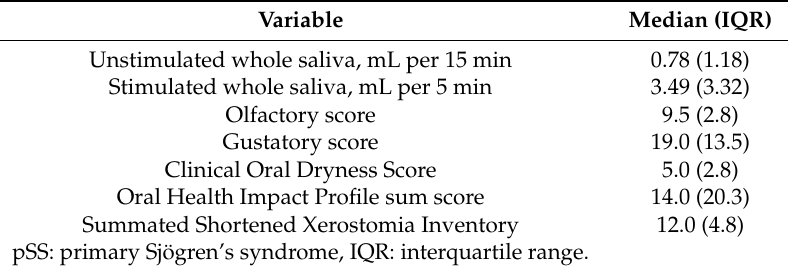
Table 6. Oral health parameters among the